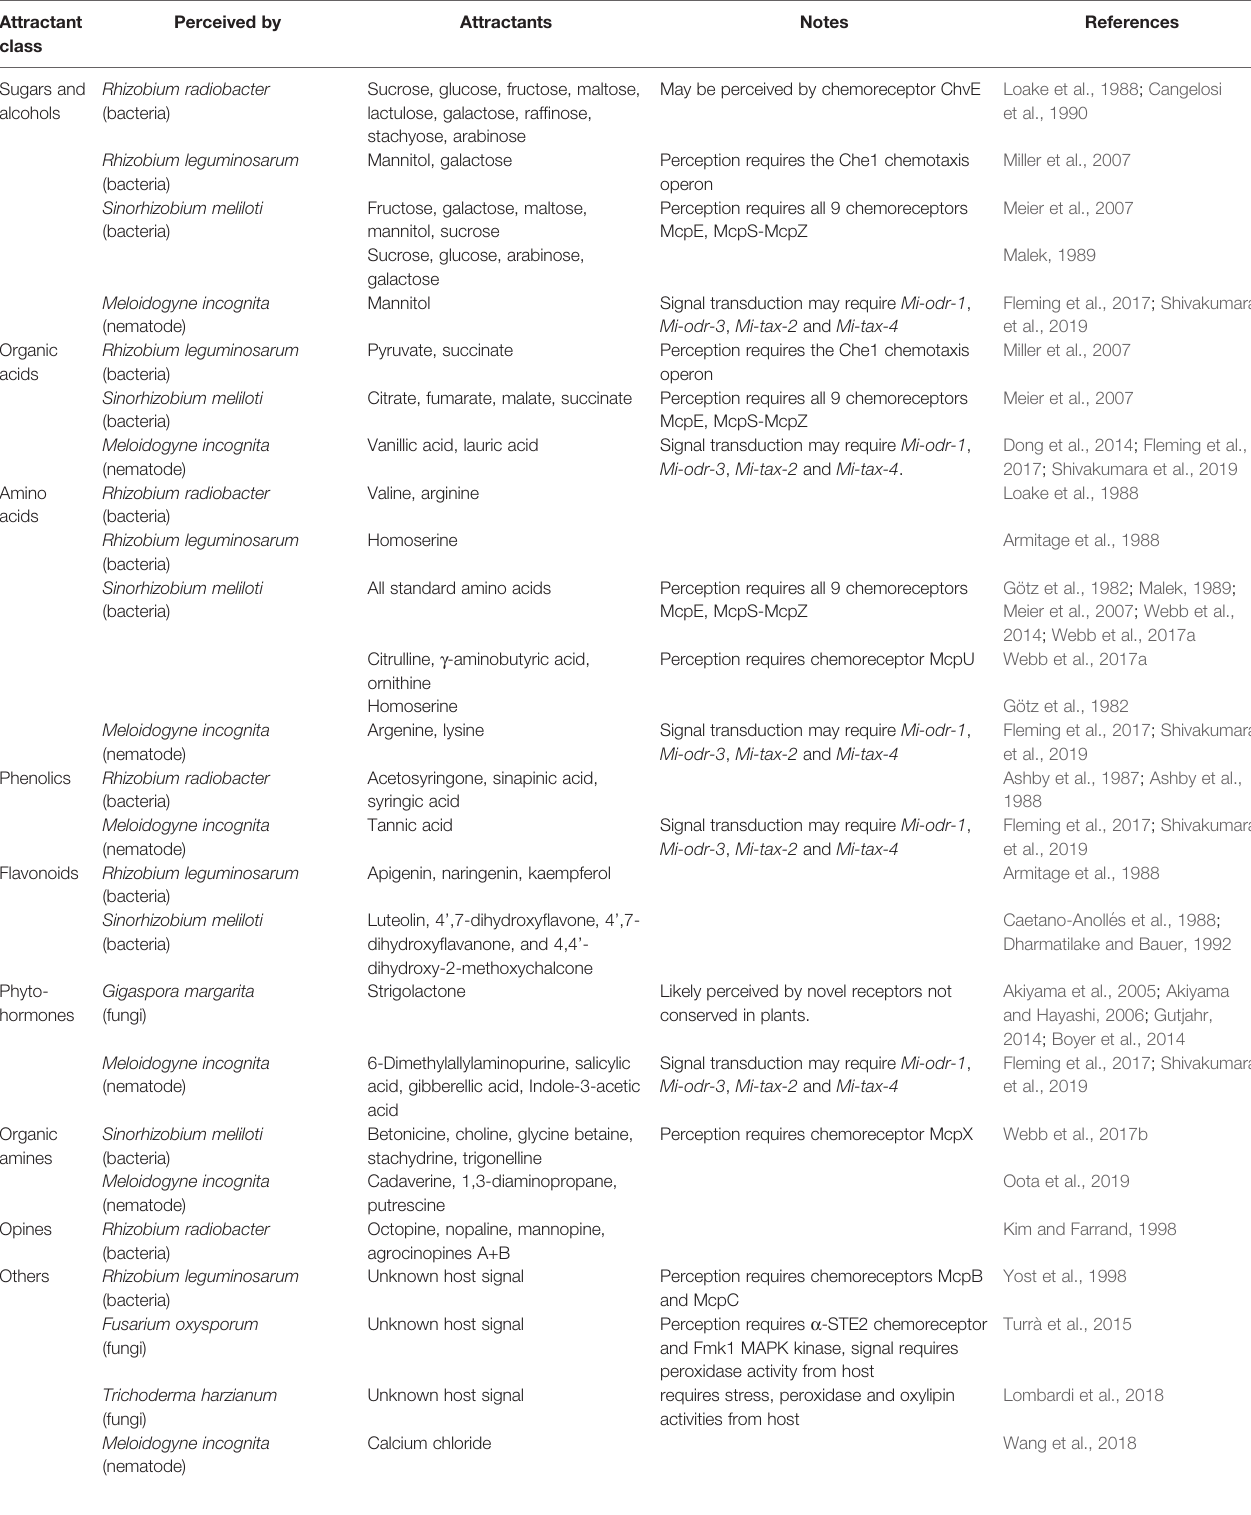
TABLE 2 | Chemoattractants of endoparasites and endophytes discussed in this